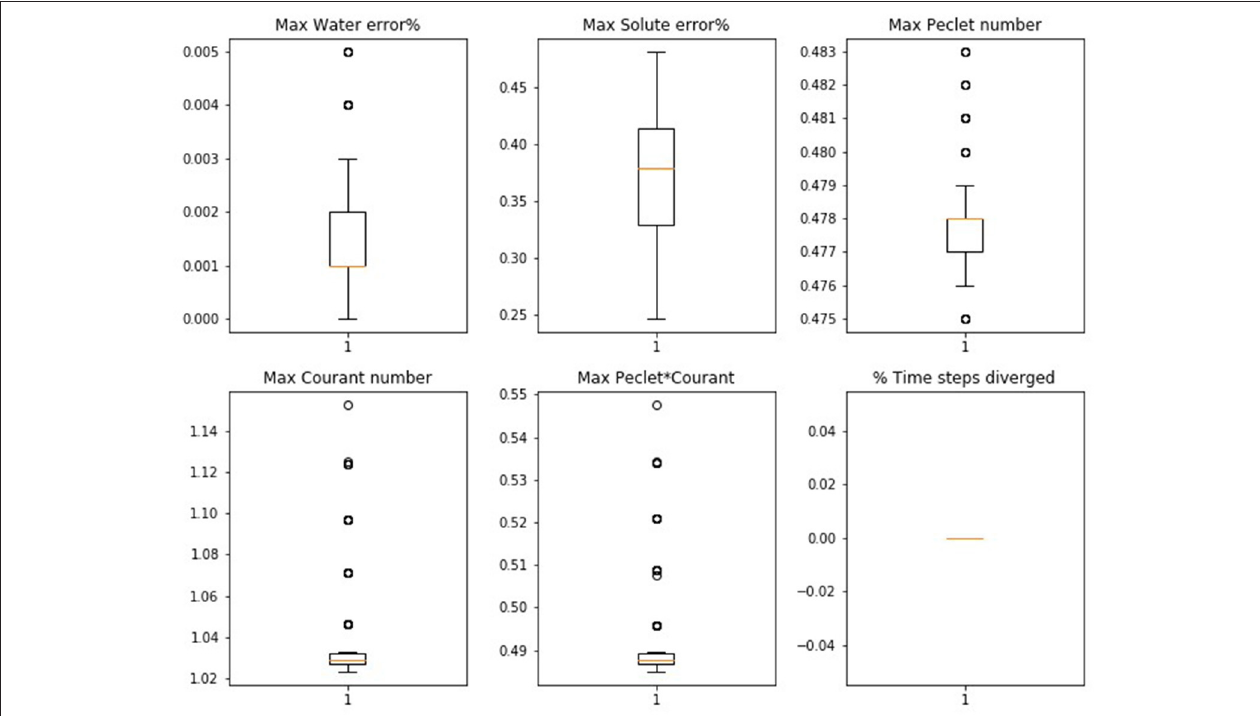
FIGURE 7 | Run time information demonstrating convergence of stochastic HYDRUS-1D